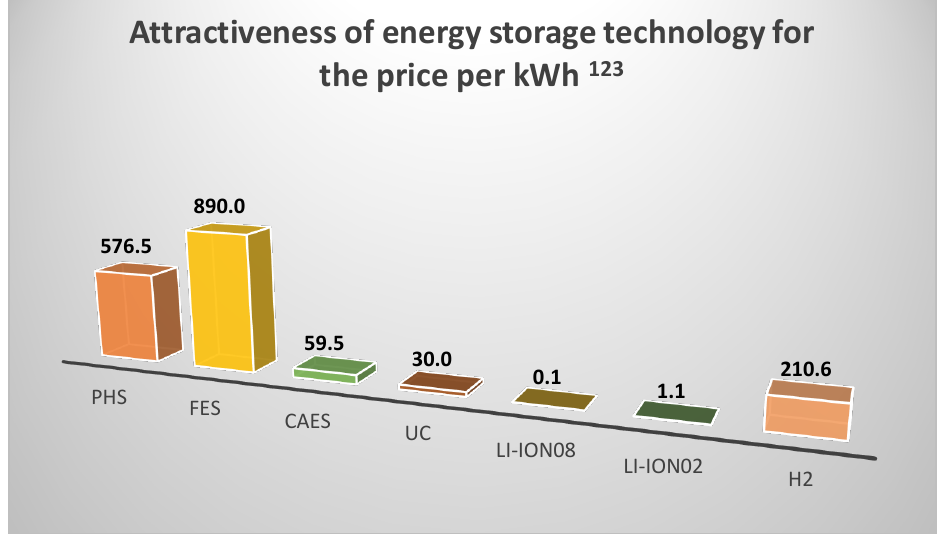
Figure 2. Energy storage technology cost effectiveness index per kWh. 1 For LI-ION08 batteries, the number of cycles is less than 3000 for single batteries, while for a set of batteries it is even less [16]. 2 For kinetic energy storage, the number of cycles is 10 7 [17]. 3 Applies to systems without adiabatic transformation [1 8 ].